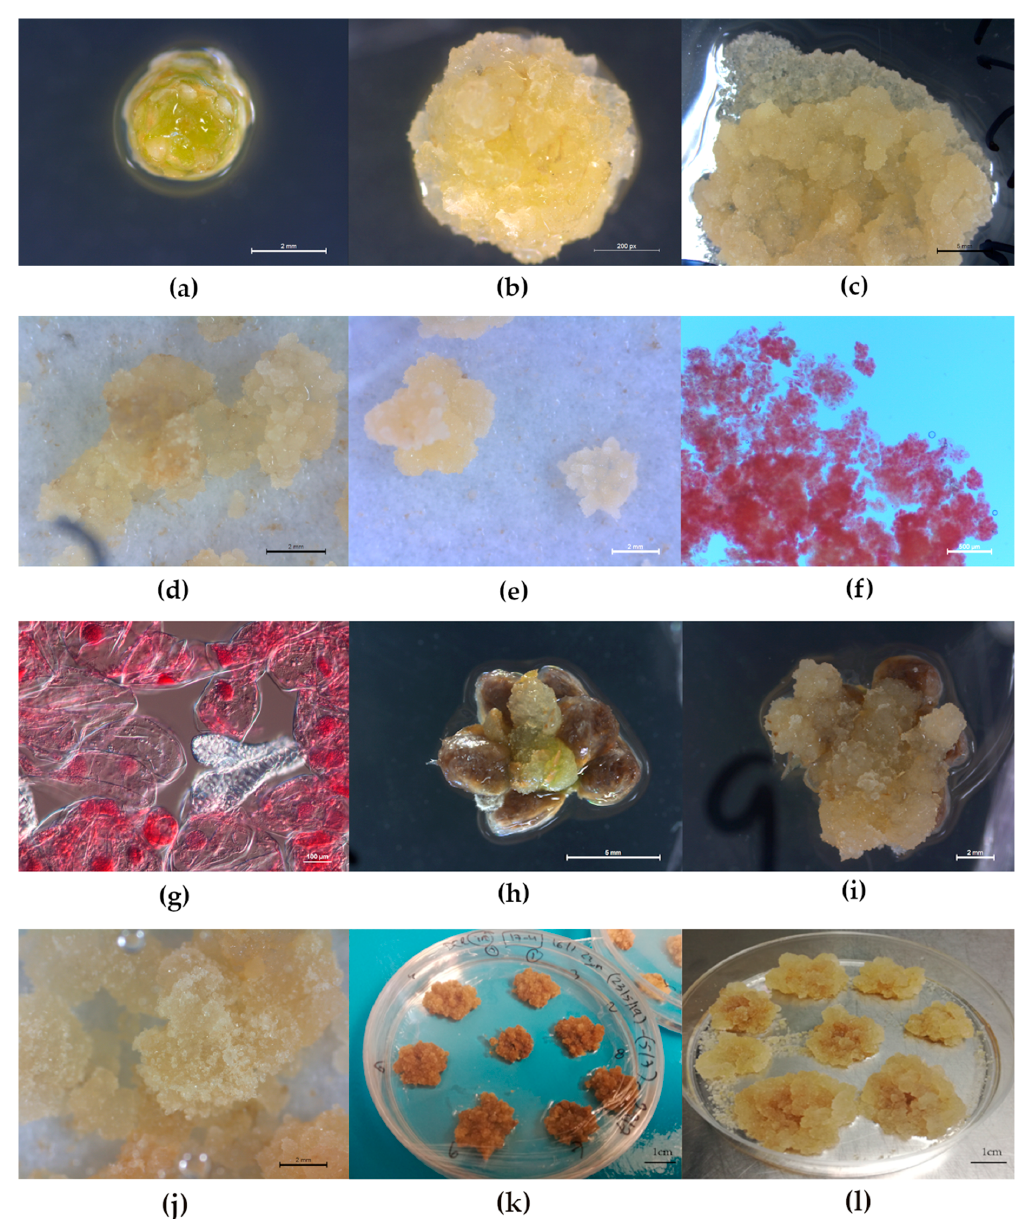
Figure 3. Induction response of apical shoot buds and axillary shoots to somatic embryogenesis (SE): ( a ) bud slice in the SE induction medium; ( b ) tissue development throughout the explant; ( c ) later proliferation of directly subcultured non-embryogenic callus; ( d ) filtered cultured tissue on the proliferation medium with 50 nM phytosulfokine; ( e ) example of non-embryogenic calli with distinct morphology in the same sample: the callus at the bottom right has more similarities with the embryogenic one; ( f ) cells collected from the lower cluster represented above, stained with acetocarmine (2% w/v ) and observed using a Leica DMS1000, showing non-polarized cells; ( g ) observation of previous cells using a Nikon ECLIPSE 80 i, demonstrating the non-embryogenic state of the calli; ( h ) bud slice in the SE induction medium with tissue development in the upper wounded area of the explant; ( i ) tissue development progress in the upper area of the explant with no tissue development throughout the whole explant; ( j ) filtered cultured tissue proliferating at 28 ◦ C; ( k ) non-embryogenic calli formed in the S11 induction medium; ( l ) non-embryogenic calli formed in the S10 induction